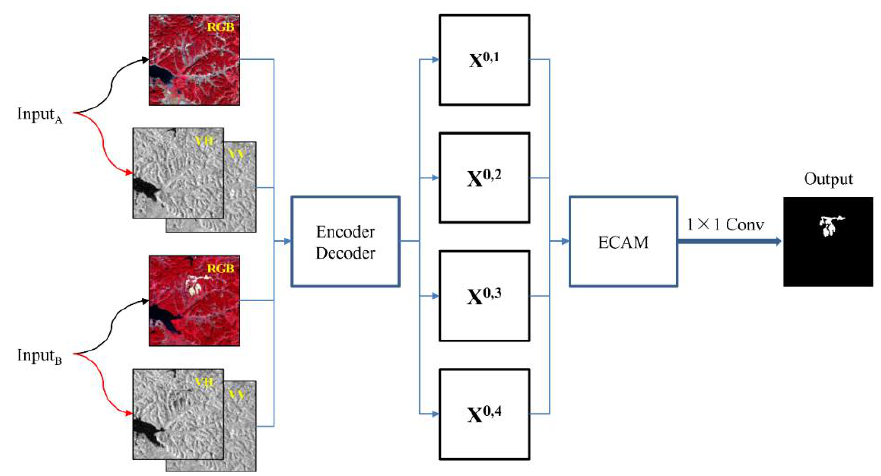
Figure 6. The pipeline of the DSNUNet. Input A and Input B are Bitemporal images (i.e., optical and SAR images).